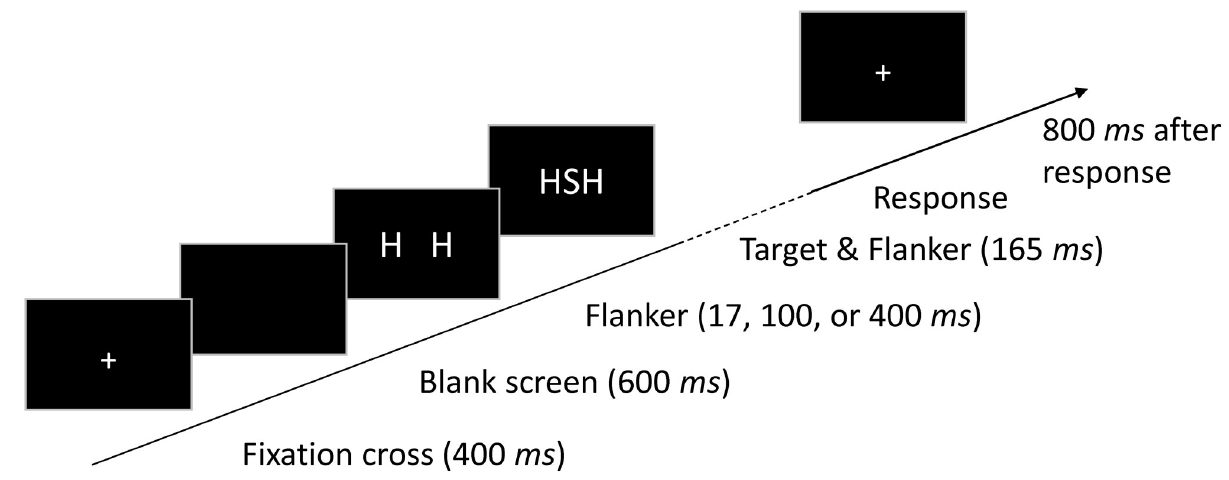
Fig 1. Procedure of Experiment 1.